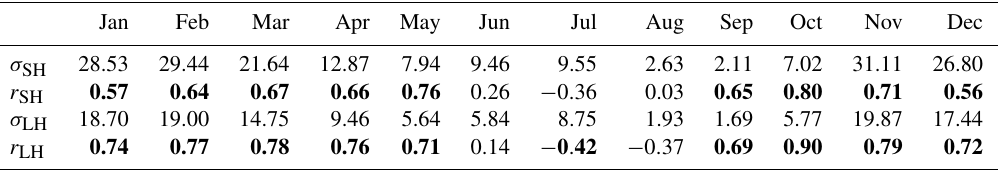
Table 3. The spatial standard deviation of sensible and latent heat flux anomalies σ SH and σ LH (Wm − 2 ) over the Arctic Ocean. r SH and r LH are correlation coefficients between SIC and sensible and latent heat flux anomalies, respectively. Those significant at a 99% confidence level are given in bold.